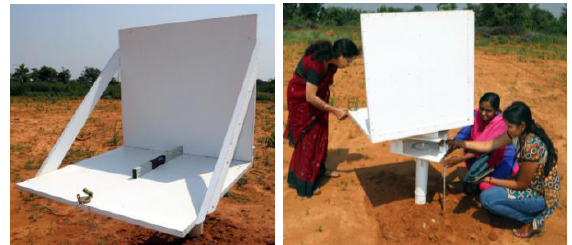
Figure 1: Corner Reflectors deployed at NRSC Microwave Cal- Val